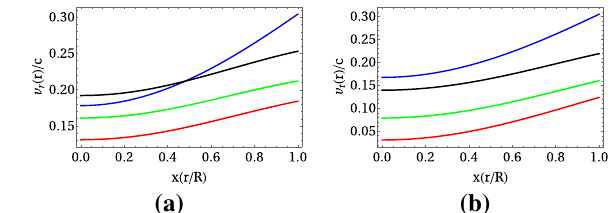
Fig. 10 Sound velocities as a function of r for compactness factor u = 0 . 2035: a radial velocity v r and b tangential v t . Models 1, 2, 3 and 4 are identified with blue, black, red and green line respectively